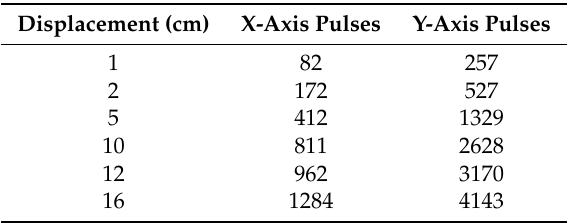
Table 1. Pulse number and displacement.